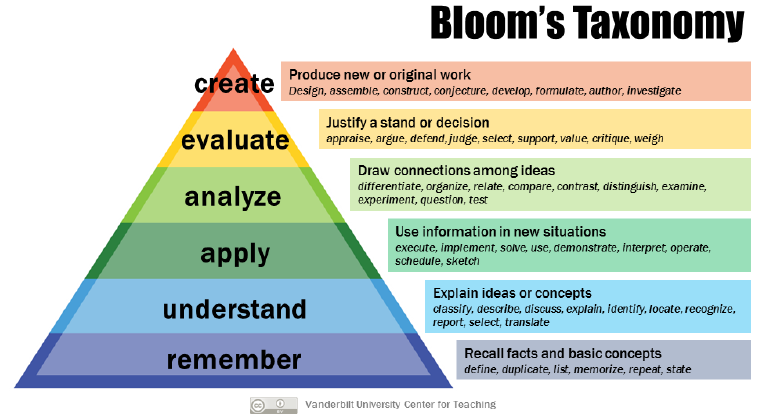
Fig. 1 - Illustration of Bloom’s revised taxonomy for the cognitive domain, with higher-order thinking skills at the top of the diagram (from